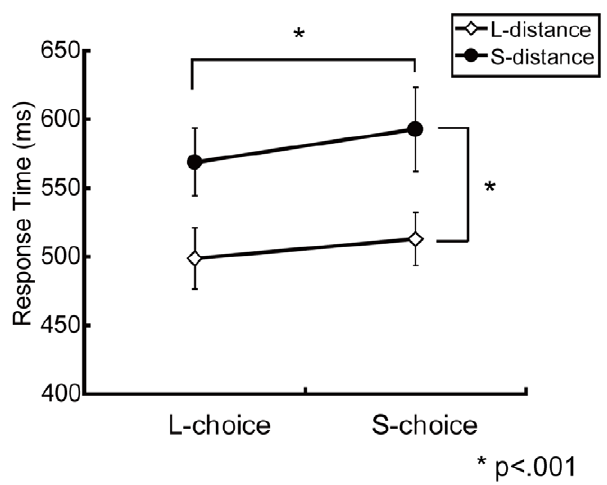
Figure 2. Average response times of 4 conditions. Error bars indicate standard errors of mean. The result of two-way ANOVA showed significant main effects of distance and choice, but no interaction between the two.